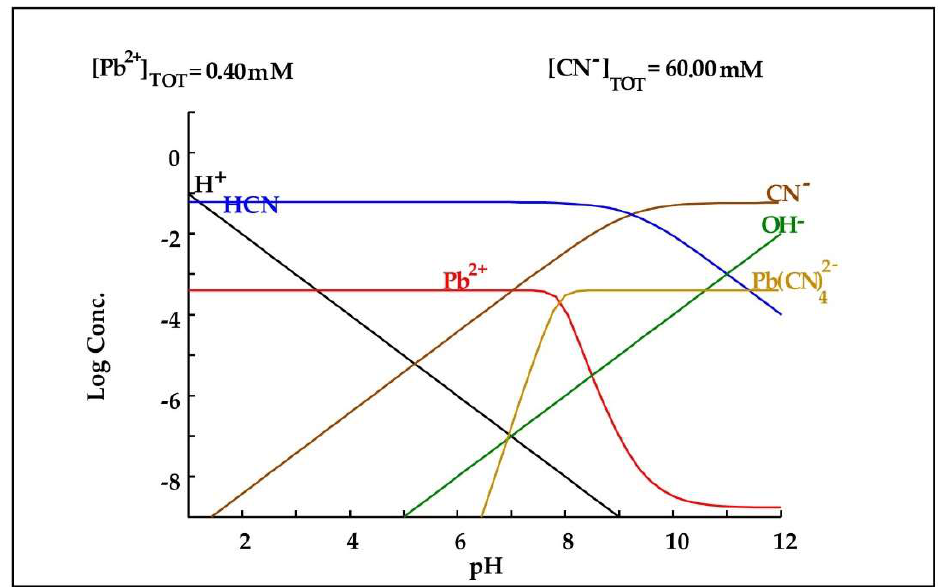
Figure 7. Diagram of distribution of species of the Pb 2+ -CN − system based on the concentrations present in the leaching medium. Diagram made by the authors in Medusa software version 2010.